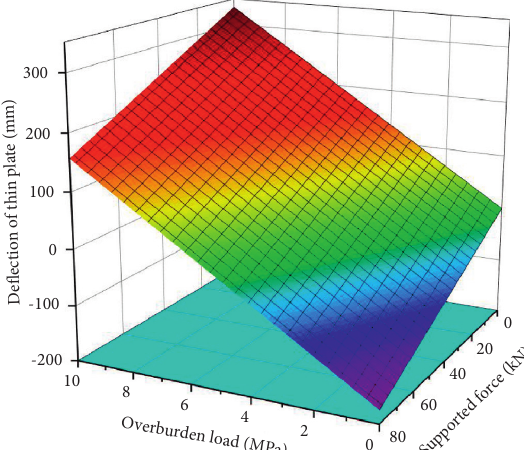
Figure 9: The response surface of roof deflection and deformation under supporting force and